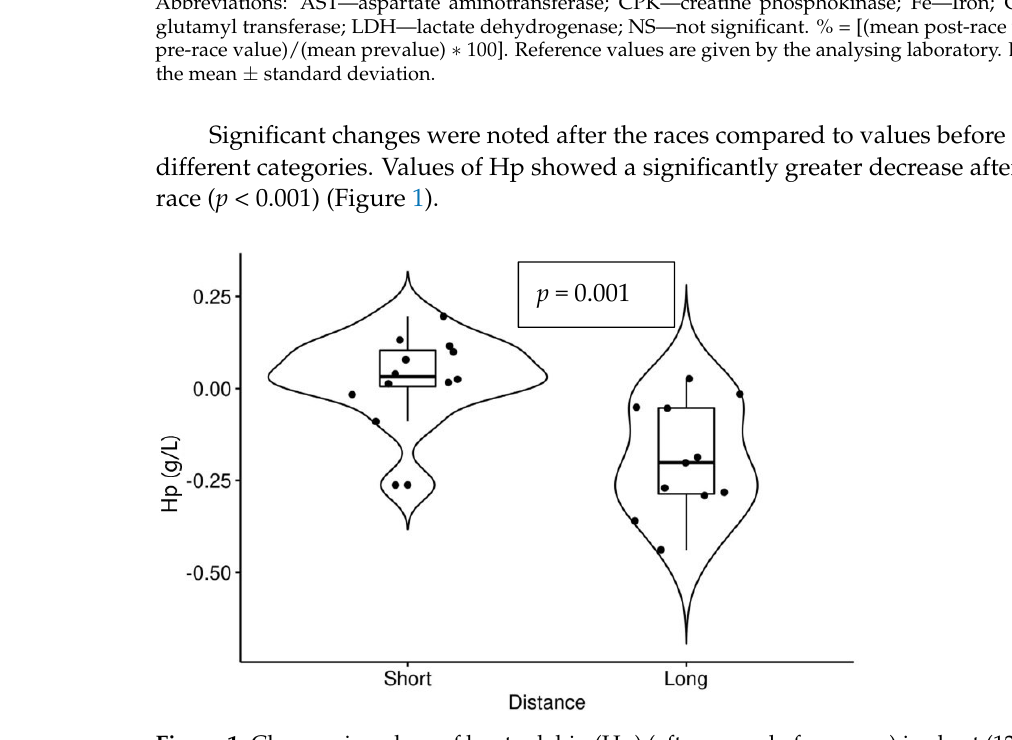
Figure 1. Changes in values of haptoglobin (Hp) (after races–before races) in short (12 horses) and long (11 horses) race distances.